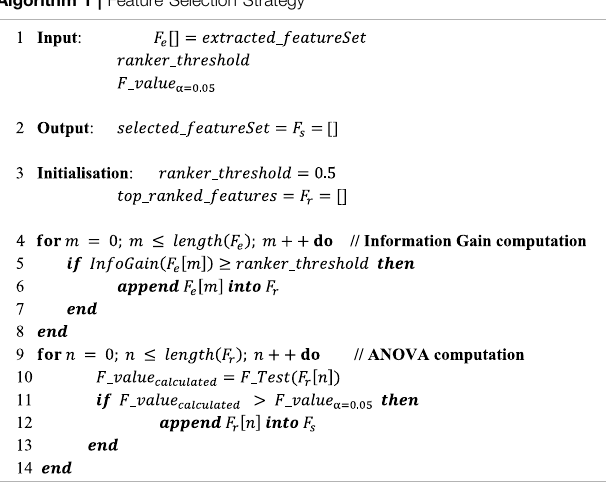
Algorithm 1 | Feature Selection